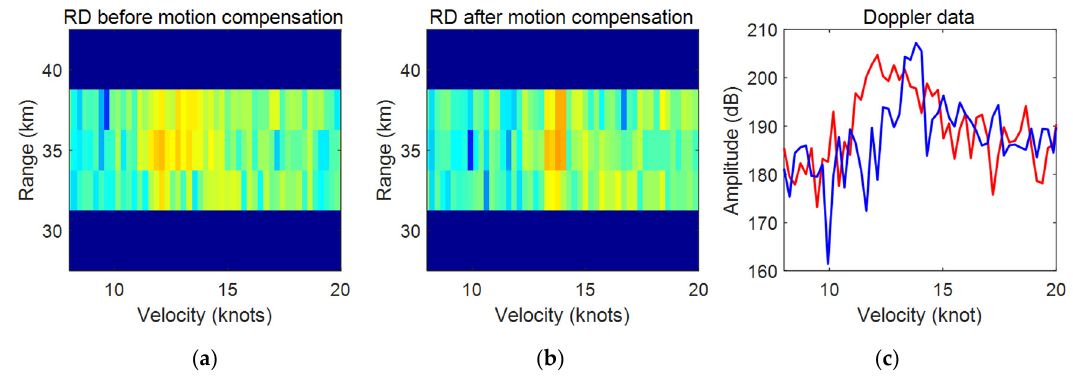
Figure 29. Target T1 Doppler spectral results before and after motion compensation during P1: ( a ) two-dimensional RD spectral results before motion compensation, ( b ) two-dimensional RD spectral results after motion compensation, and ( c ) one-dimensional spectral results before and after motion compensation.